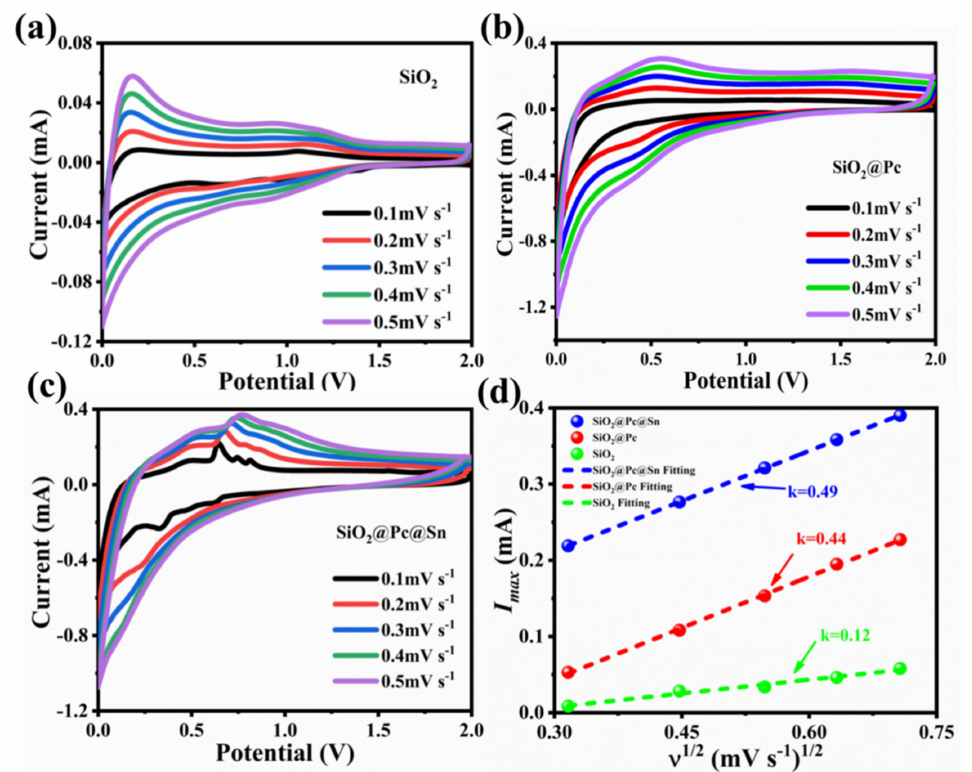
Figure 6. ( a – c ) CV curve of SiO 2 , SiO 2 @Pc, and SiO 2 @Pc@Sn with different scanning rates of 0.1–0.5 mV · s − 1 ; ( d ) relationship between scan rate and peak